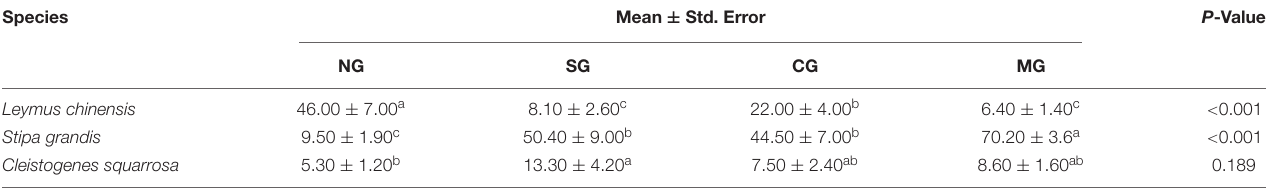
TABLE 1 | Mean proportion of aboveground biomass (%) contributed by species at twelve sites on typical steppe, Inner Mongolia, with different grazing systems. Species Mean ± Std. Error